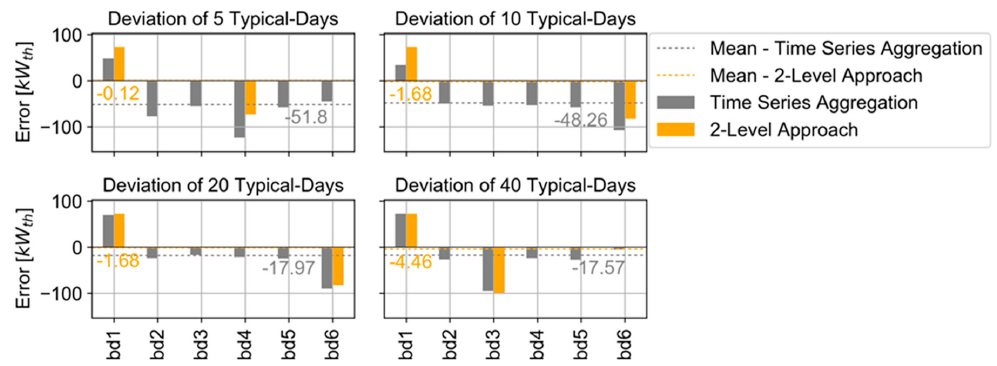
Figure 6. Deviation of installed boiler capacities with the 2-Level Approach and time series aggregation in buildings (bd) compared to full time series. in buildings (bd) compared to full time